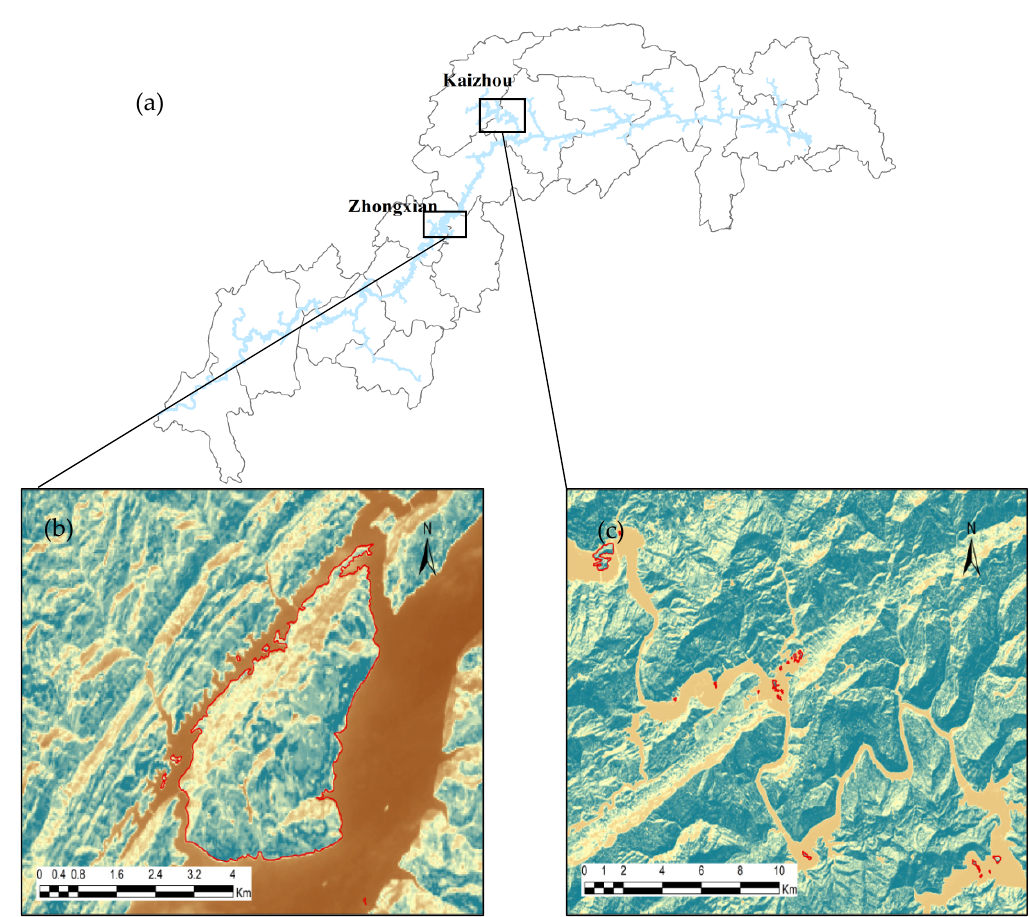
Figure 11. MCBs formed by the flooding of low-lying mountain tops: ( a ) Three Gorges Reservoir Area, ( b ) in Zhongxian and ( c ) in Kaizhou.